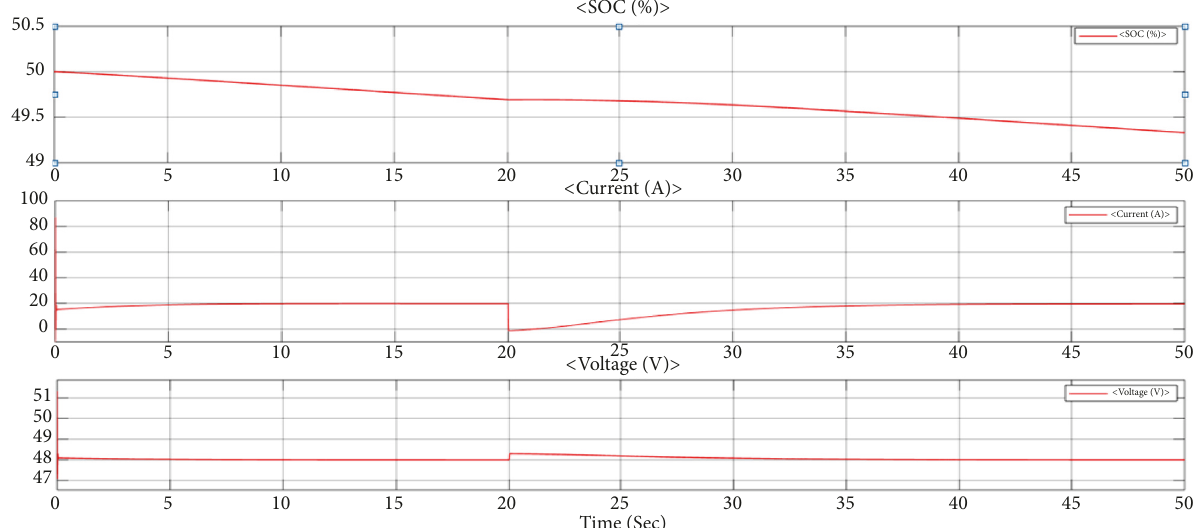
Figure 20: The battery characteristic SOC, current, and